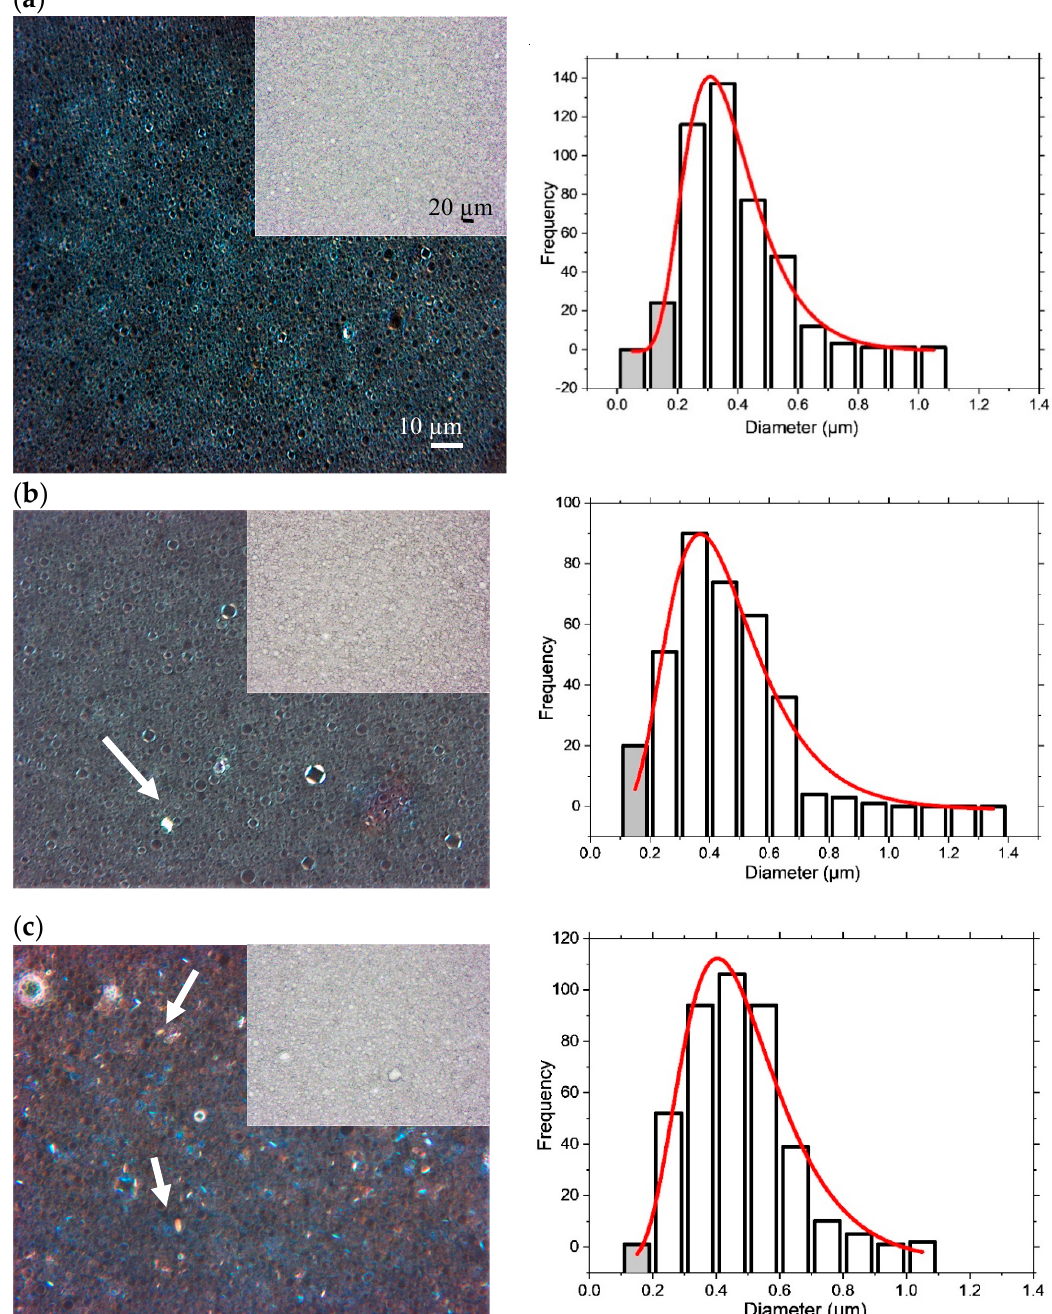
Figure 1. Bright-field and polarised light photomicrographs (left) (at room temperature) of one-day-old 10% creams prepared with a 1:1 ( a ; C4), 1:0 ( b ; C5) or 0:1 ( c ; C6) hexadecanol:octadecanol co-surfactant ratio. Arrows in the polarised light micrographs indicate examples of crystal-like structures. The corresponding oil-droplet diameters measured from the bright-field images are fitted to log-normal distributions (right). The number frequencies of oil droplets with sizes < 0.2 microns carry high uncertainties (because the sizes fall below the resolution limit of visible light, 200 nm), and these data are highlighted by shaded bars. Cream compositions are detailed in Methods, Table 1.